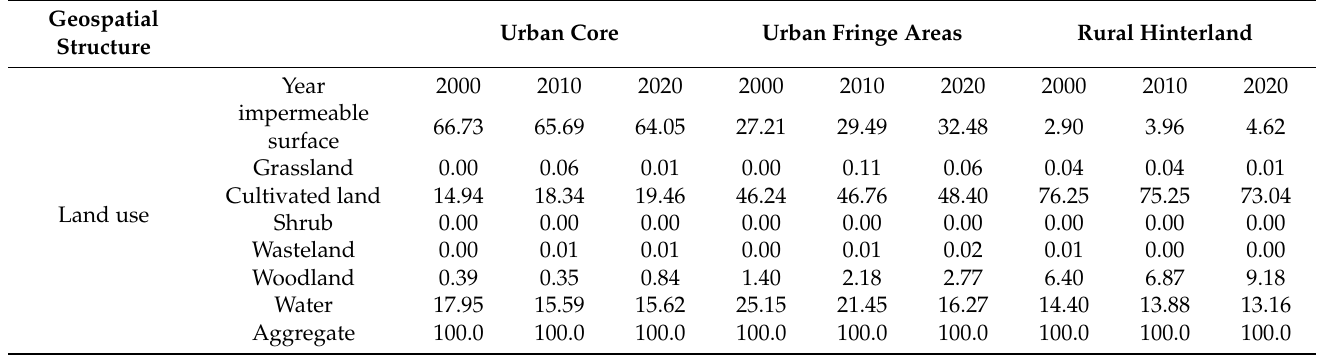
Table 10. Land-use area in Wuhan, 2000–2020 (unit: